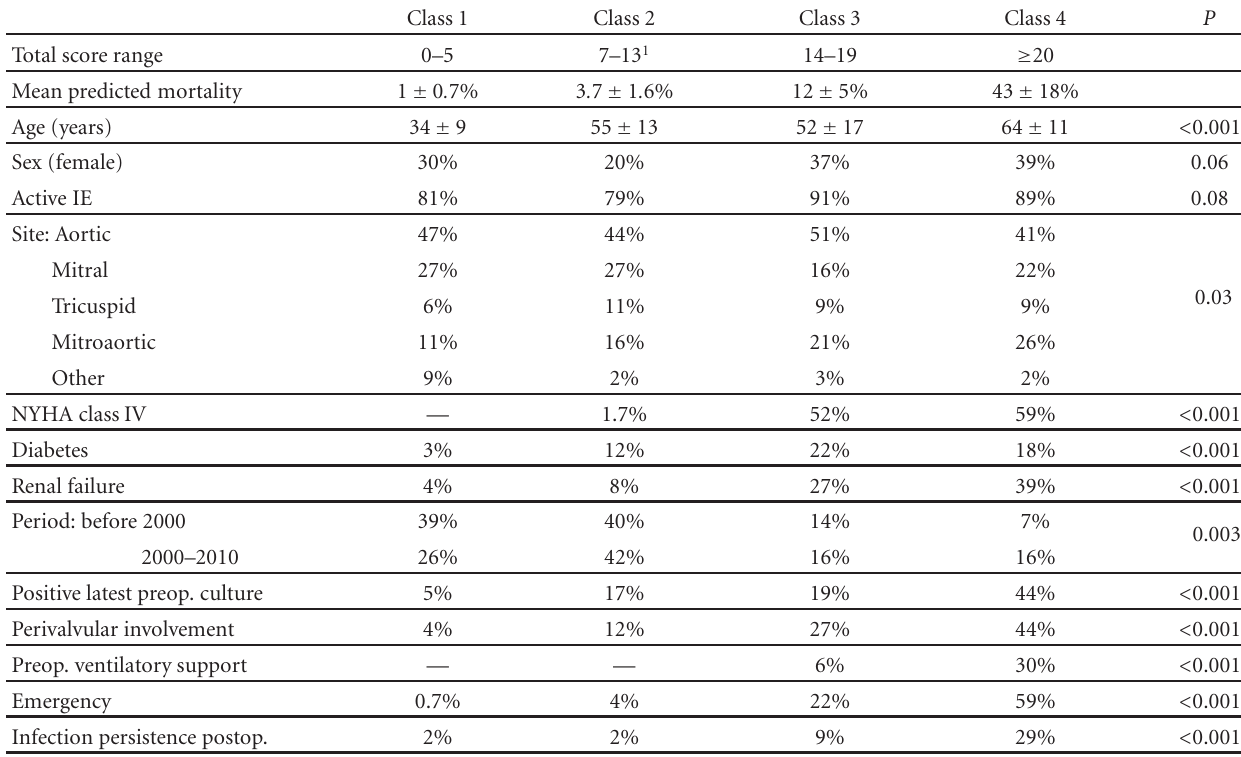
Table 3: Definition of the 4 risk groups according to total score and comparisons in terms of clinically relevant